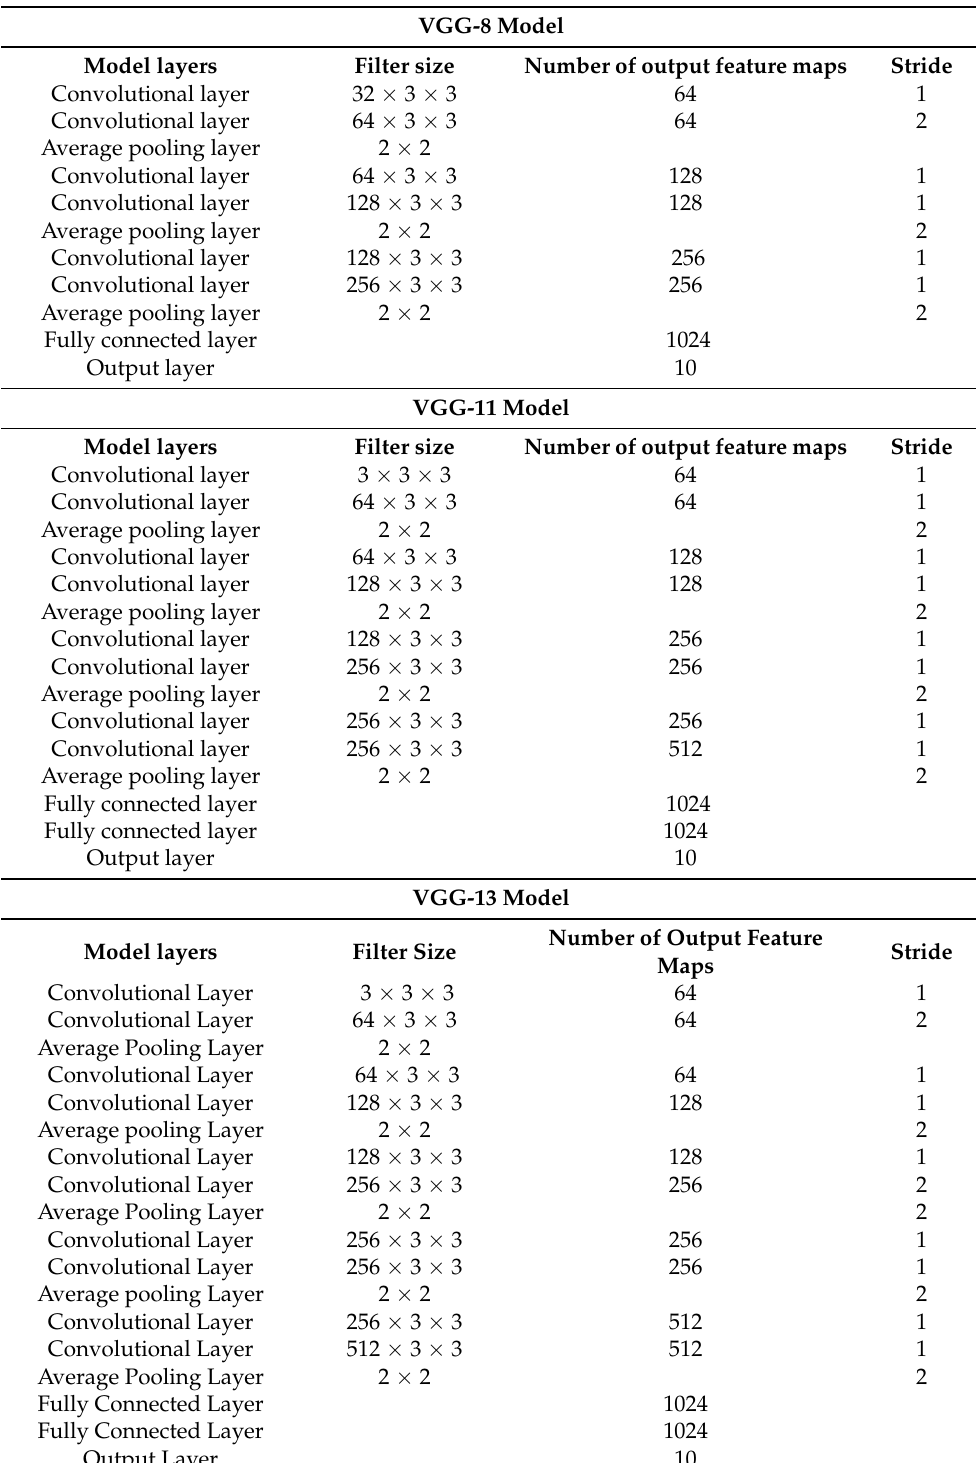
Table 4. Proposed DCSNN models for Street View House Number(SVHN) and CIFAR-10